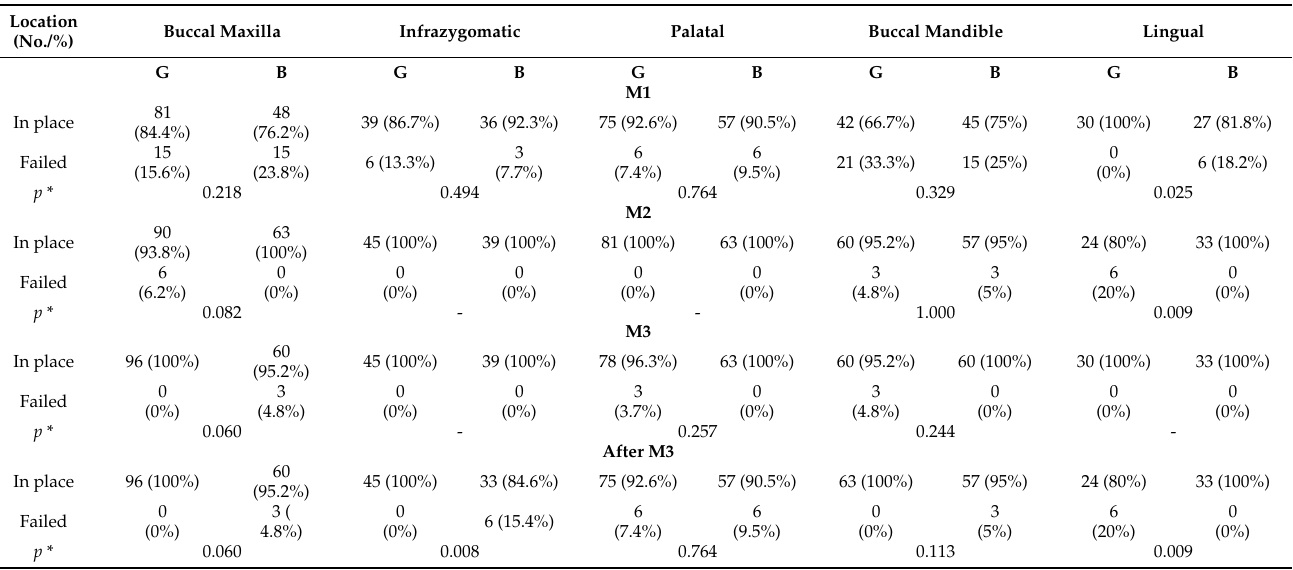
Table 5. Distribution of the mini-implants according to gender, insertion site and rejection rate in M1, M2, M3 and after M3.